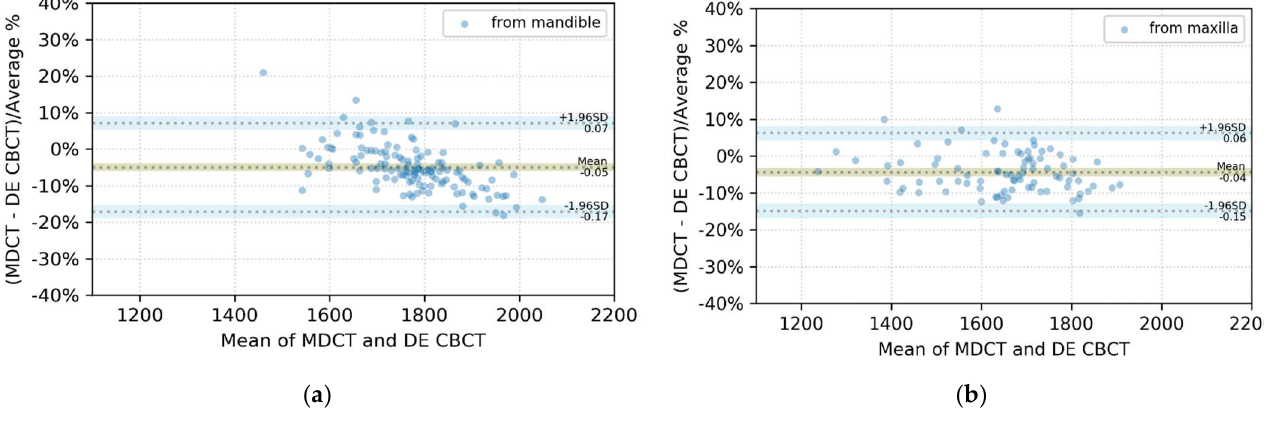
7 of 10 Table 2. Deviation ranges and region of interest (ROI) numbers and percentages within each deviation range.